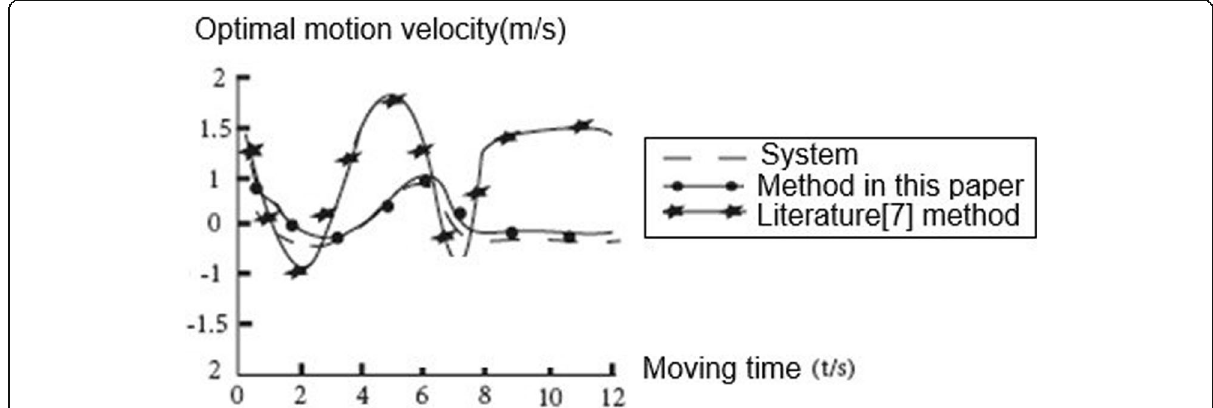
Fig. 6 Comparison chart of the movement velocity of the steady swing stage of the inverted